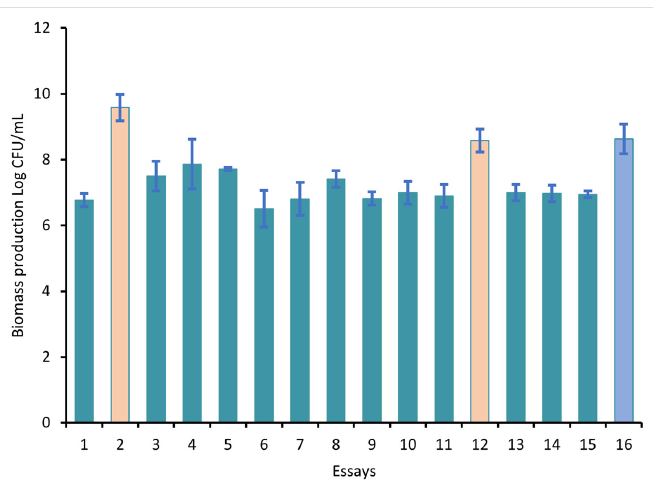
Figure 3. Growth of biomass of Lactobacillus paracasei ssp. paracasei (F-19) in 16 Box–Behnken design (BBD) combination nutrients for optimized culture media, Log CFU/mL: logarithm colony forming units/milliliter.